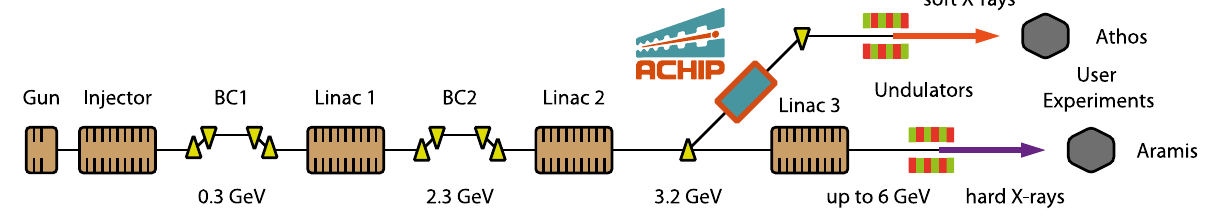
FIG. 1. Schematic of the free-electron laser SwissFEL at PSI. The ACHIP chamber is located in the switch-yard to the Athos beamline at a beam energy of 3.2